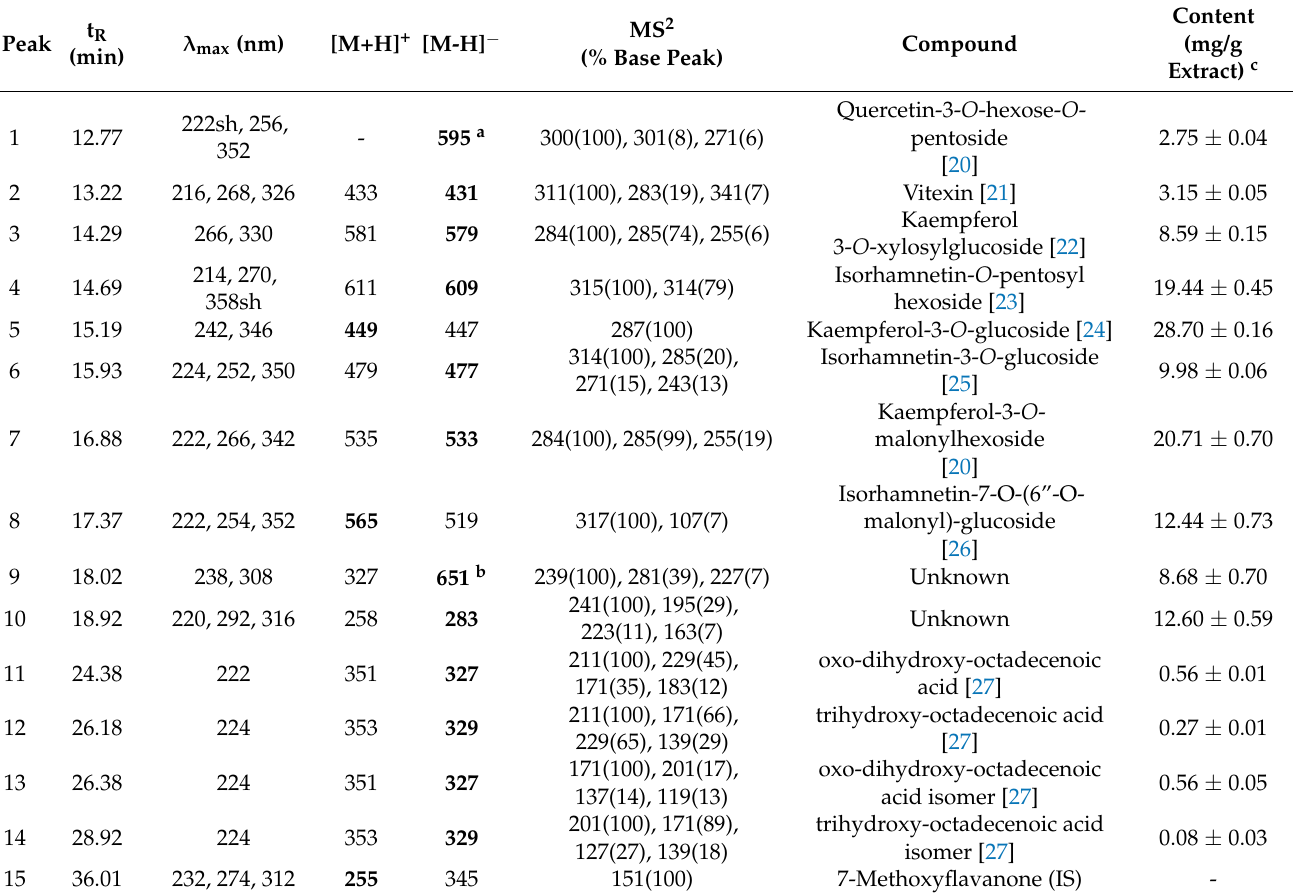
Table 2. Retention time (t R ), UV-Vis and ESI Mass spectral characteristics of isolated components in pepino leaf extracts.